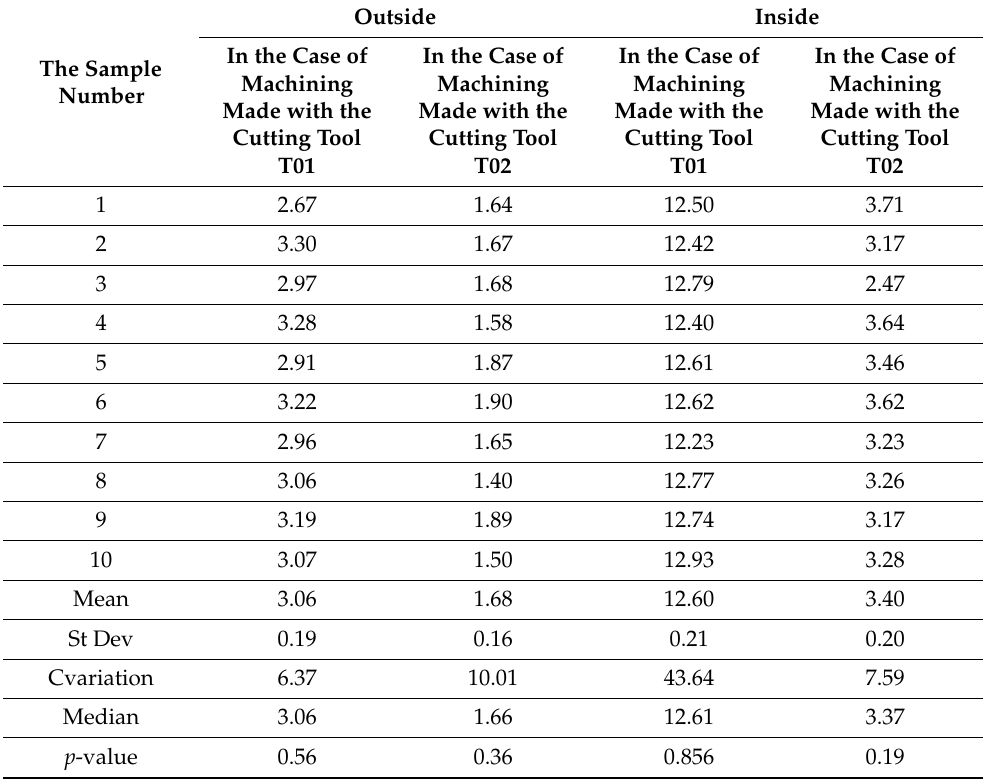
Table 4. The measured roughness values for the 10 samples, Ra ( µ